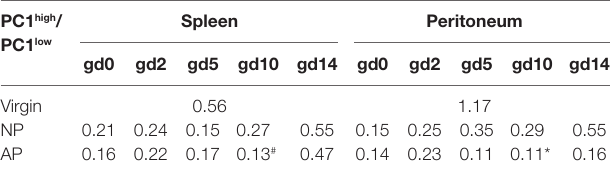
The frequencies of CD19 + CD5 + PC1 high and CD19 + CD5 + PC1 low were determined in spleen and peritoneum from virgin (n = 5 per organ), NP (n = 4–7 per organ), and AP (n = 5–6 per organ) females at different gestation days (gds), and the ratio between both B1a B cell subpopulations was calculated. Data are displayed as medians. Statistical analysis was performed using the Mann–Whitney-U test (*p ≤ 0.05 vs NP; # p ≤ 0.05 vs virgin; and Ψ p ≤ 0.01 vs virgin). NP, normal pregnant; AP, abortion TaBle 3 | The PC1 high /PC1 low ratio was significantly reduced in peritoneum from AP females on gd10.